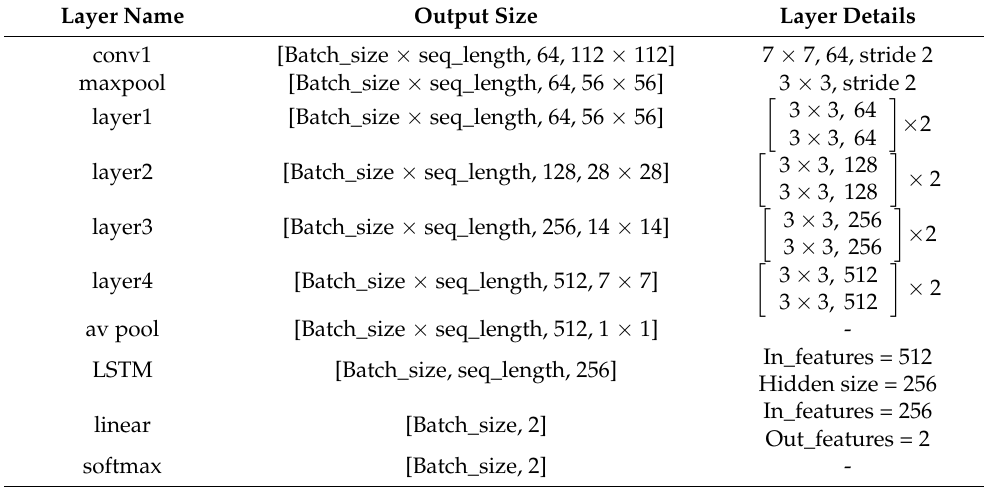
the details of the resnet layers show the filter size, number of feature maps, and number of block